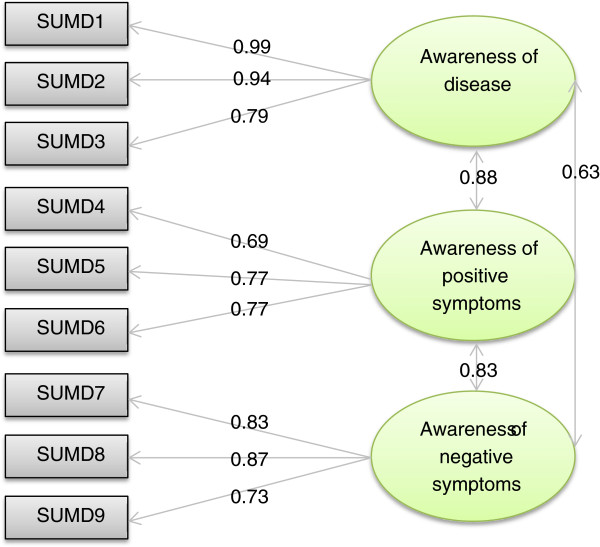
LISREL confirmatory structural model (model 2, data imputation). SUMD1: Awareness of a mental disorder, SUMD2: Awareness of the consequences of a mental disorder, SUMD3: Awareness of the effects of drugs, SUMD4: Awareness of a hallucinatory experience, SUMD5: Awareness of delusional ideas, SUMD6: Awareness of disorganised thoughts, SUMD7: Awareness of blunted affect, SUMD8: Awareness of anhedonia, SUMD9: Awareness of lack of sociability.